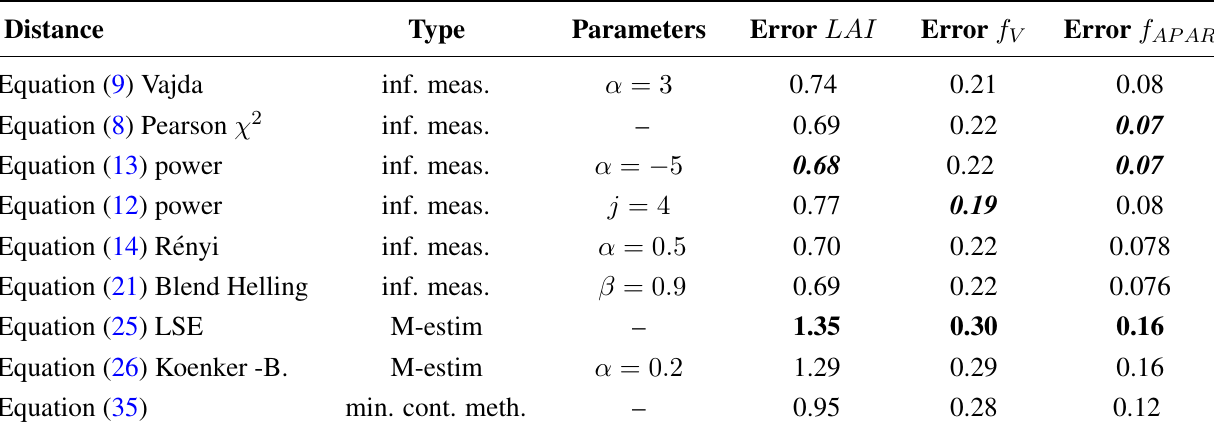
Table 5. Summary statistics for the estimation of biophysical parameters from ground reflectance values (BRF) for needleleaf